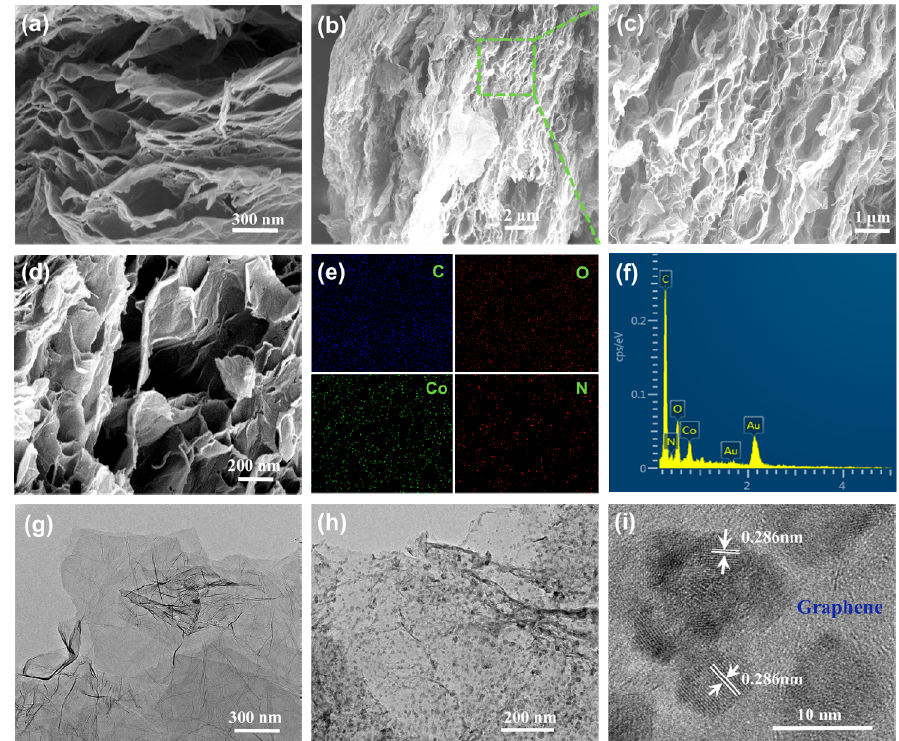
Figure 3. Microstructure characteristics of samples: ( a ) Scanning electron microscopy (SEM) images of AG, ( b – d ) SEM images of the Co 3 O 4 /AG nanocomposite, ( e ) and ( f ) elemental mapping and EDS of the Co 3 O 4 /AG nanocomposite, ( g ) and ( h ) transmission electron microscope (TEM) micrographs of AG and the Co 3 O 4 / AG nanocomposite, and ( i ) HRTEM micrograph of the Co 3 O 4 / AG nanocomposite.